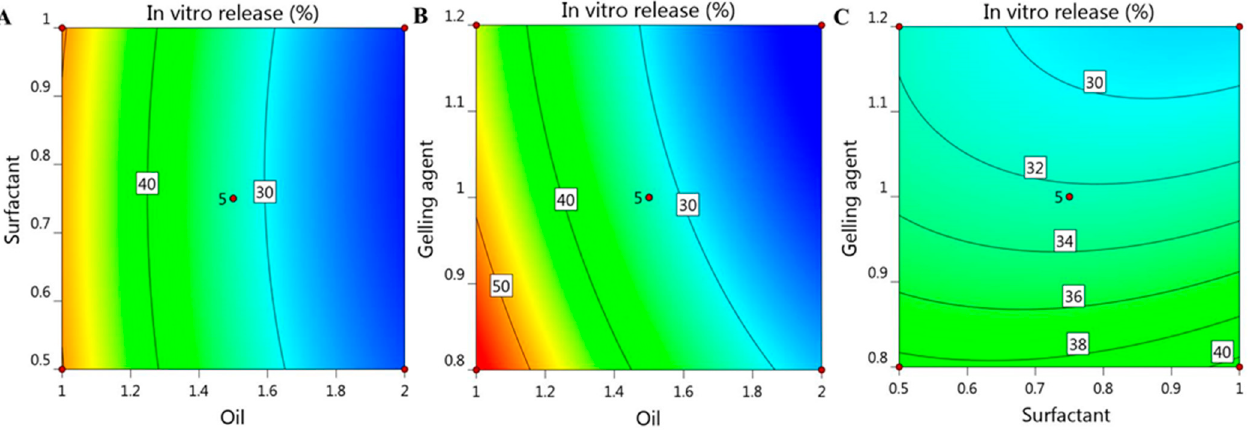
Figure 7. 2D contour graph representing the effect of independent factors ( A ) X 1 and X 2 , ( B ) X 1 and X 3 , and ( C ) X 2 and X 3 on in vitro release response (R 2 ).